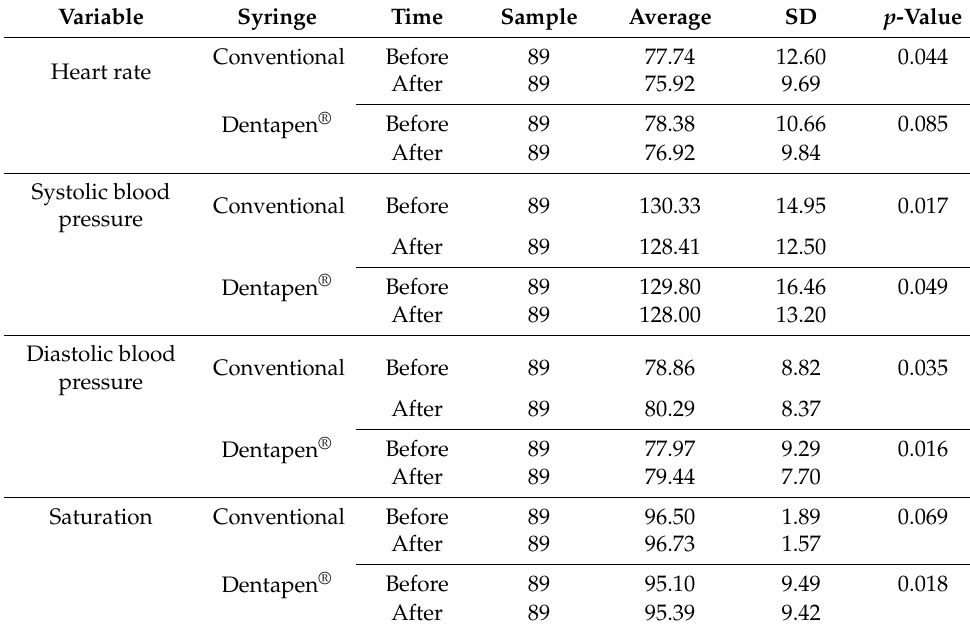
Table 6. Heart rate, systolic and diastolic blood pressure, and saturation comparison, plus statistical significance after the use of conventional and Dentapen ®